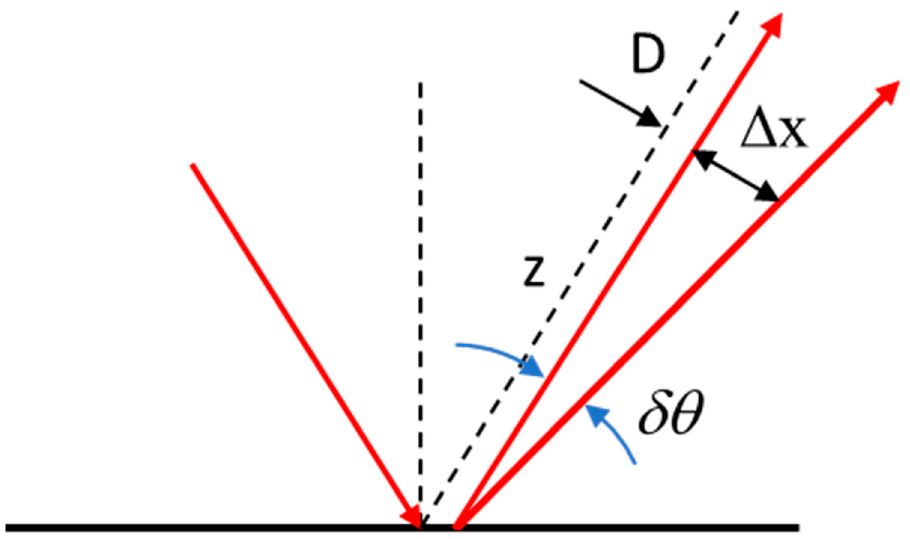
Figure 13. Reflection of an incident beam at a diffraction grating.